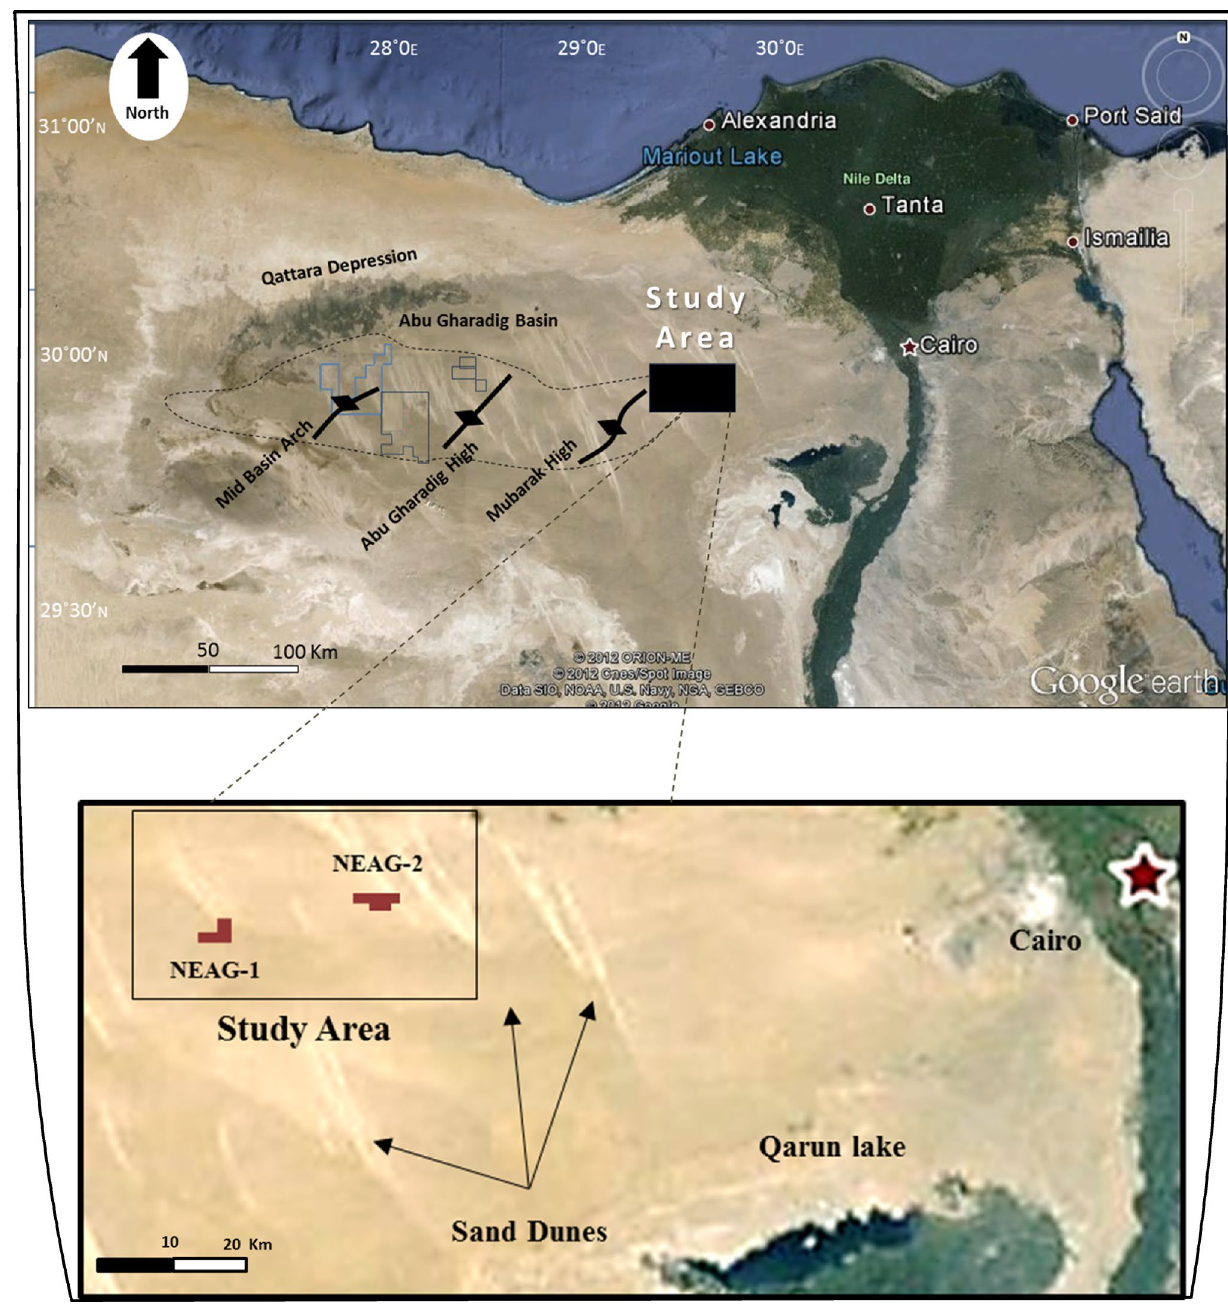
Fig. 1 Location map of the study area (Google Earth Maps